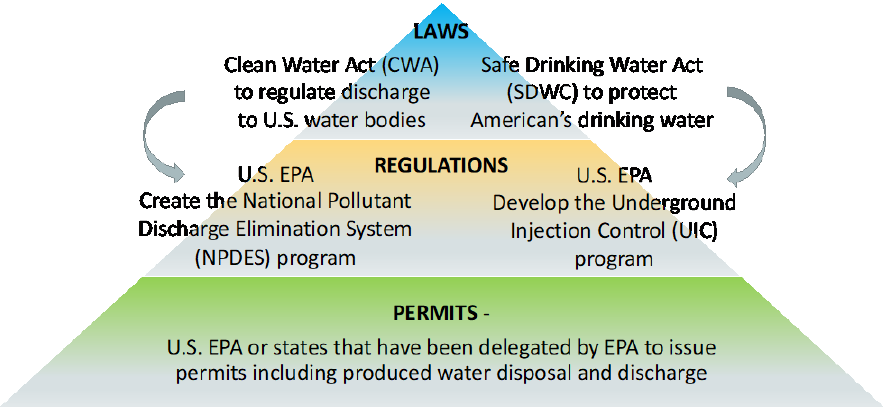
Figure 2. The U.S. legal and regulatory framework for produced water management.